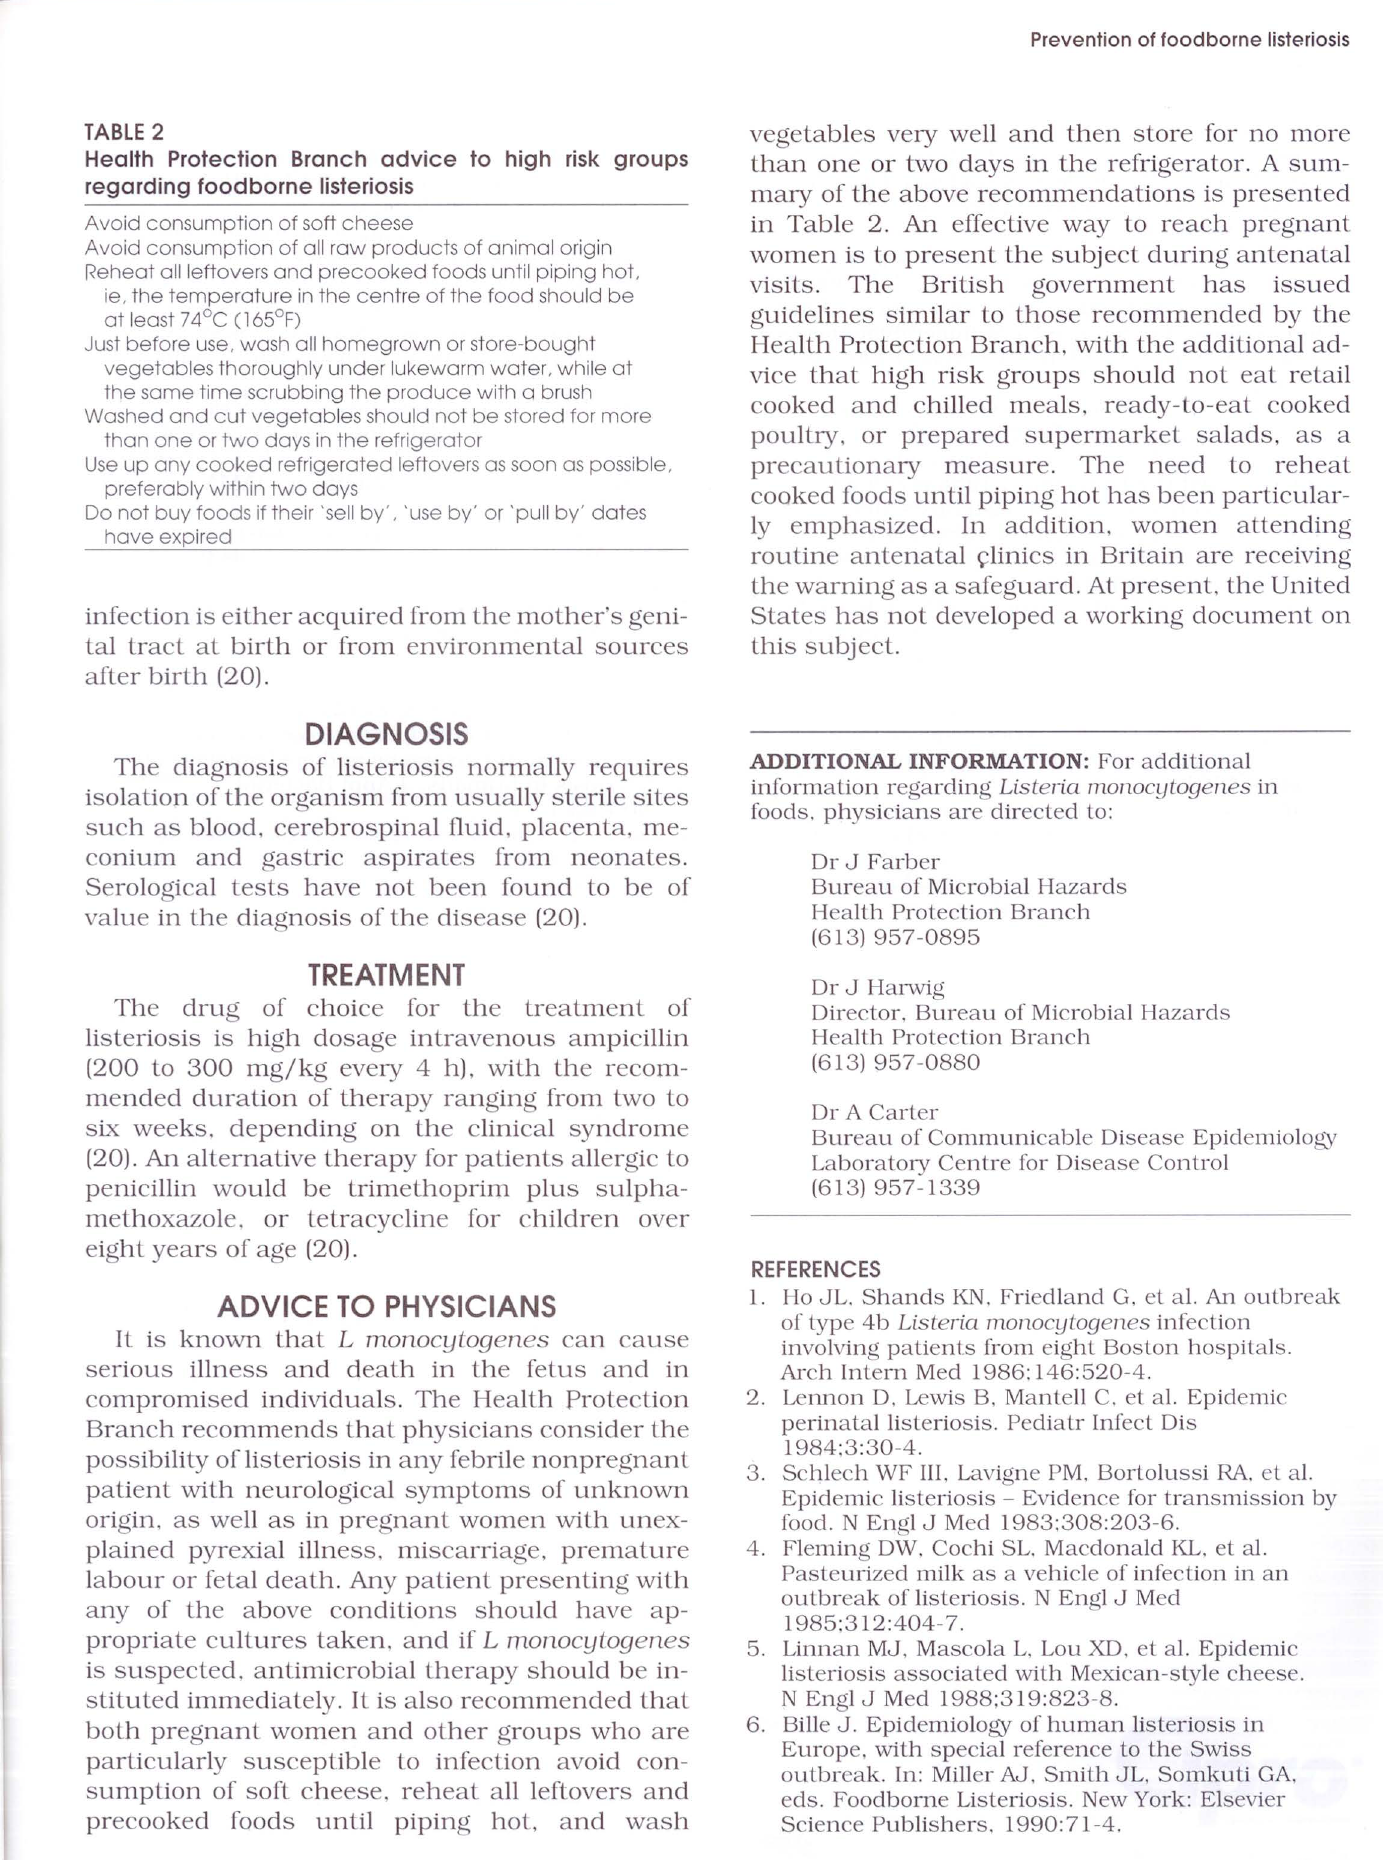
Health Protection Branch advice to high risk groups regarding foodborne